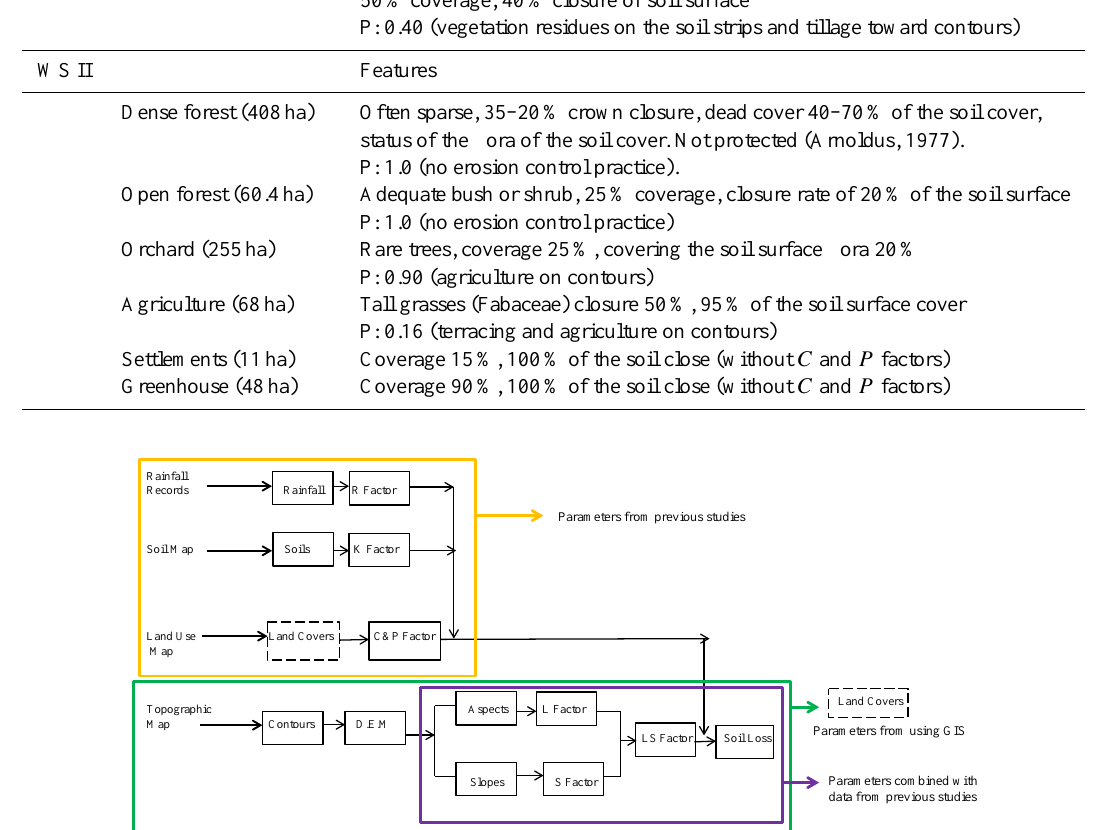
Figure 2. Flow chart to estimate a coefficient using the USLE in the study (adapted from Fistikogli and Harmancioglu, 2002).